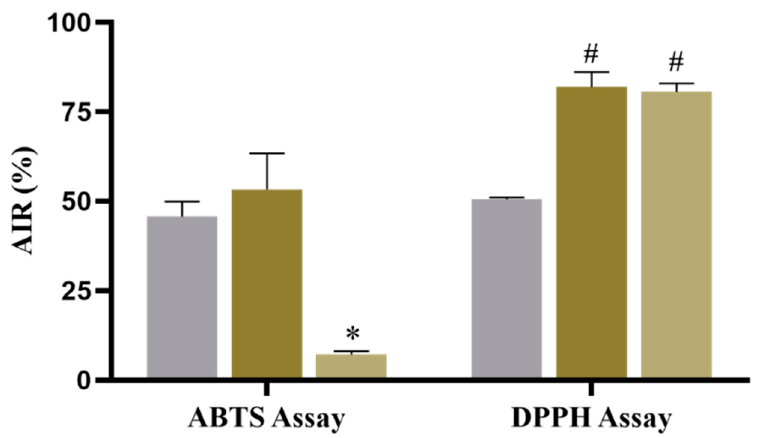
Figure 1. Percentage ABTS • + and DPPH • radical inhibition activity (AIR) of the essential oils Figure 1. Percentage ABTS •+ and DPPH • radical inhibition activity (AIR) of the essential oils of Myr- Figure 1. Percentage ABTS •+ and DPPH • radical inhibition activity (AIR) of the essential oils of Myr- Figure 1. Percentage ABTS •+ and DPPH • radical inhibition activity (AIR) of the essential oils of Myr- of Myrciaria floribunda and Myrcia sylvatica . The results are expressed as the mean and standard ciaria floribunda and Myrcia sylvatica . The results are expressed as the mean and standard deviation ciaria floribunda and Myrcia sylvatica . The results are expressed as the mean and standard deviation Figure 1. Percentage ABTS •+ and DPPH • radical inhibition activity (AIR) of the essential oils of Myr- ciaria floribunda and Myrcia sylvatica . The results are expressed as the mean and standard deviation deviation ( n = 3). * p = 0.0001 versus Trolox and Myrciaria floribunda ; # p = 0.0001 versus Trolox. ( n = 3). * p = 0.0001 versus Trolox and Myrciaria floribunda ; # p = 0.0001 versus Trolox. = Myrciaria ( n = 3). * p = 0.0001 versus Trolox and Myrciaria floribunda ; # p = 0.0001 versus Trolox. = Myrciaria ciaria floribunda and Myrcia sylvatica . The results are expressed as the mean and standard deviation ( n = 3). * p = 0.0001 versus Trolox and Myrciaria floribunda ; # p = 0.0001 versus Trolox. = Myrciaria ( n = 3). * p = 0.0001 versus Trolox and Myrciaria floribunda ; # p = 0.0001 versus Trolox. = Myrciaria floribunda; = Myrcia sylvatica; = floribunda; = Myrcia sylvatica; = Trolox. floribunda; = Myrcia sylvatica; = Trolox. floribunda; = Myrcia sylvatica; = Trolox.